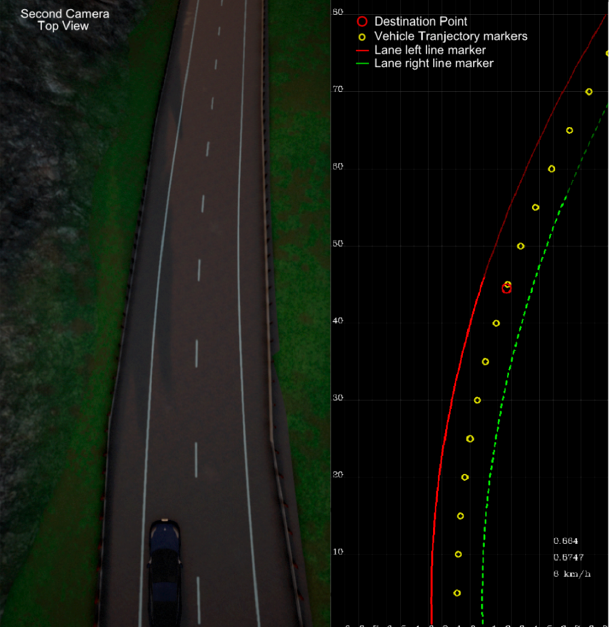
Figure 12. Left: camera view above the car for comparison with line detection data. Right: visualization of line detection (red-lane left, green-lane right) with destination point and trajectory markers obtained from Mobileye camera view as in Figure 13.